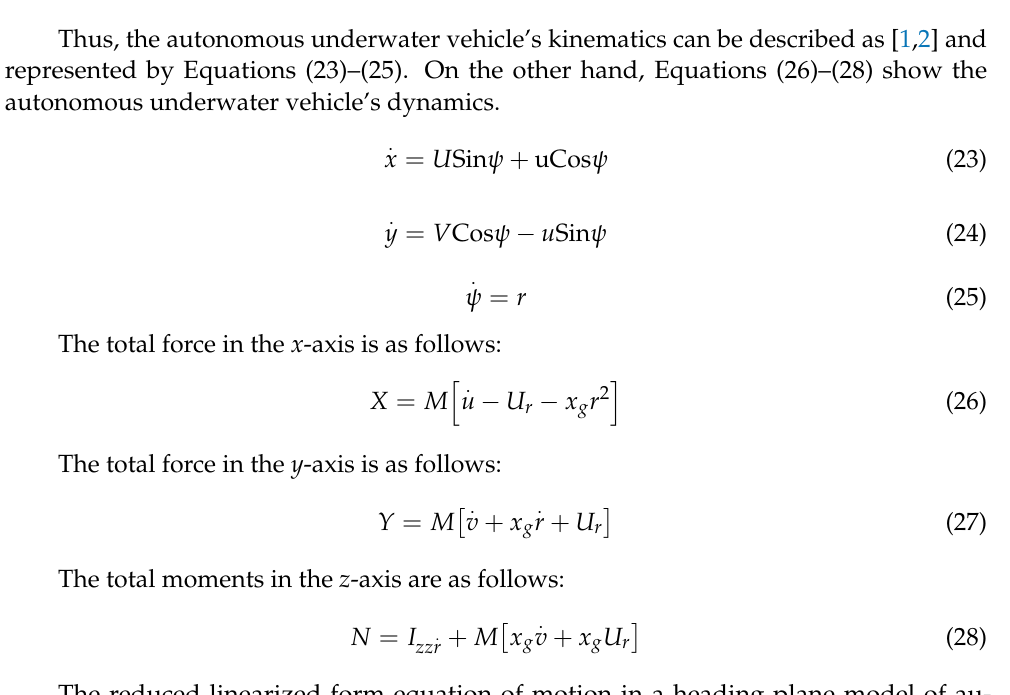
Table 2. Value of linearized coefficient. Parameter Value Units Description − 0.58 kg Mass (added) X . u Z w − 46.003 kg · m/s Combined term Z q − 6.534 kg · m/s Combined term − 23.899 kg Mass (added) Z . w Z . 1.9986 kg · m Mass (added) q − 39.04 kg · m/s 2 Fin lift Z δ s M w 20.026 kg · m/s Combined term M θ − 3.49236 Hydrostatic force M . 3.12 kg · m w M . q Table 3. Autonomous underwater vehicle’s inertia value along various axes. Inertia Value Units I xx 0.05398 kg · m 2 I yy 1.2697 kg · m 2 I zz 1.2799 kg · m